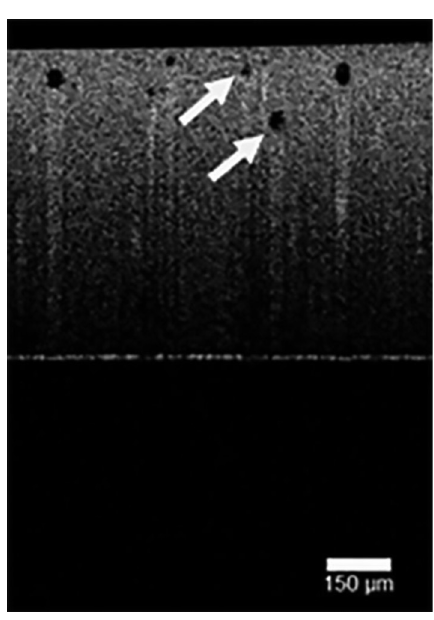
FIGURE 7 - Tomographic image of the emulsified system ES-3 (1:10 dispersion in purified water). The arrows indicate droplets of different sizes in the emulsion’s inner